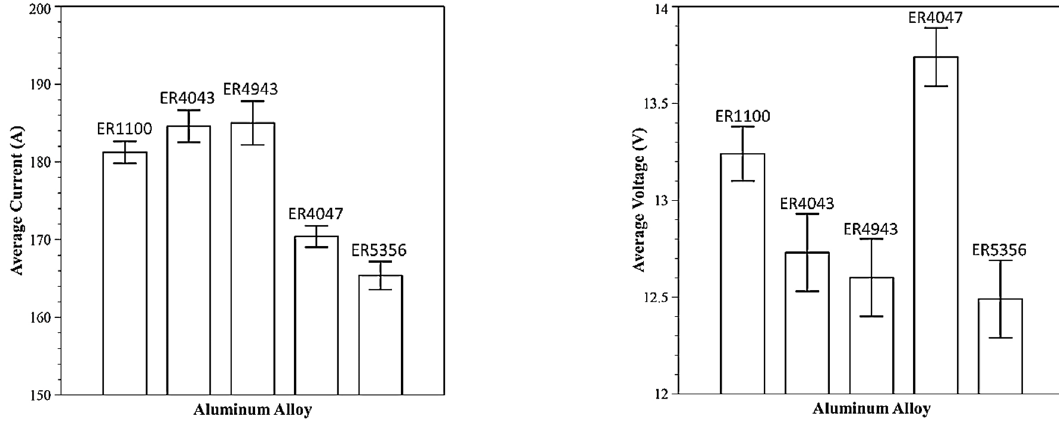
Figure 8. Average current ( left ) and average voltage ( right ) of all five aluminum alloys. Error bars represent ±2 standard error ( ≈ 95% confidence).